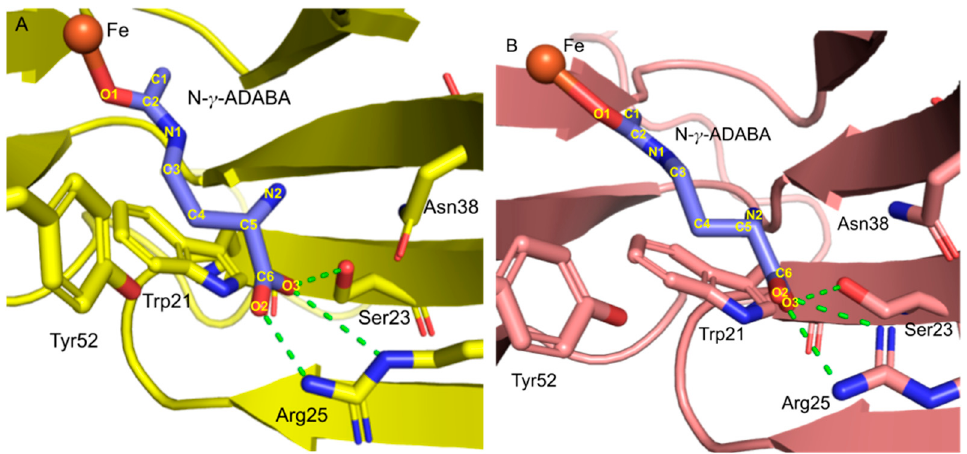
Figure 9. The centroid geometries for dominating clusters from 100-ns-long MD for the model with four-coordinate Fe 2+ and Trp21-B: ( A ) active site in monomer 1; ( B ) active site in monomer 2. Hydrogen bonds are shown as green dashed lines.